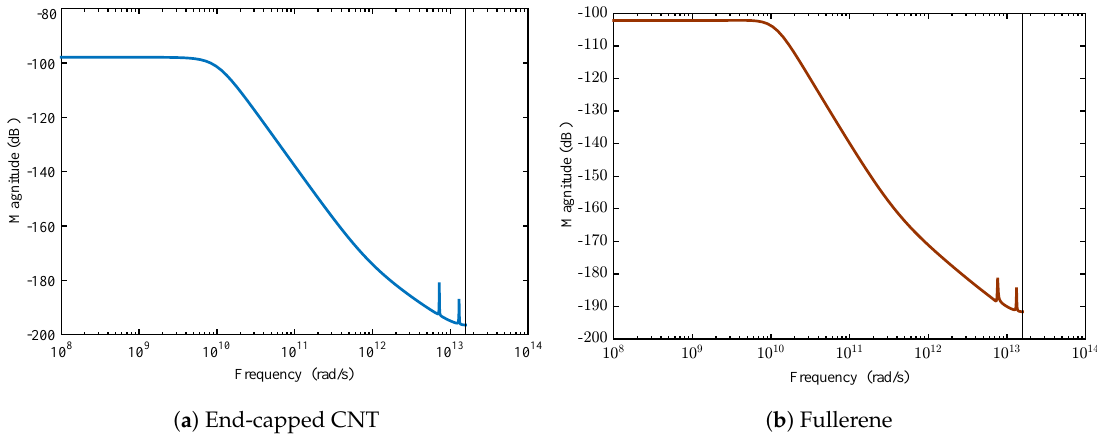
Figure 9. Bode diagram for the identified